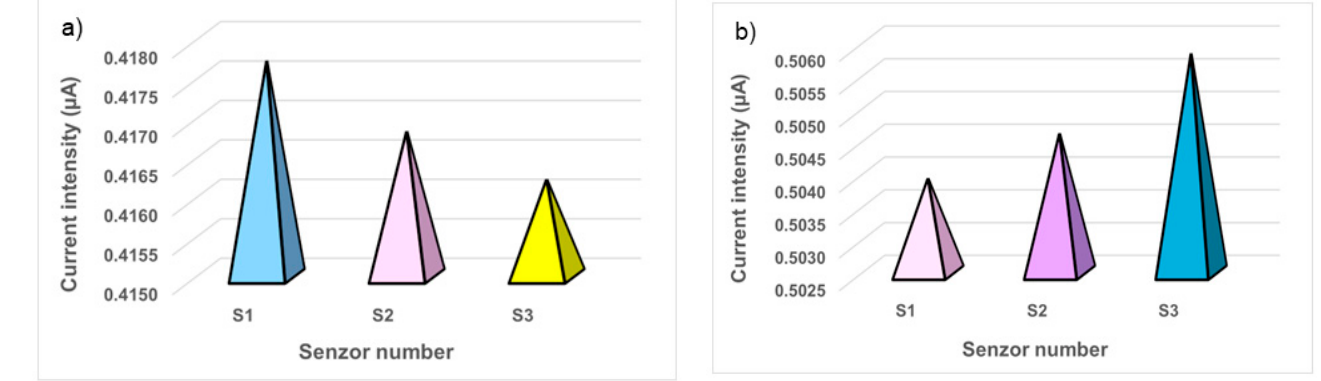
Figure 9. Reproducibility of the ( a ) PIX/AuNPsnGr and ( b ) PIXCoCl/AuNPsnGr .